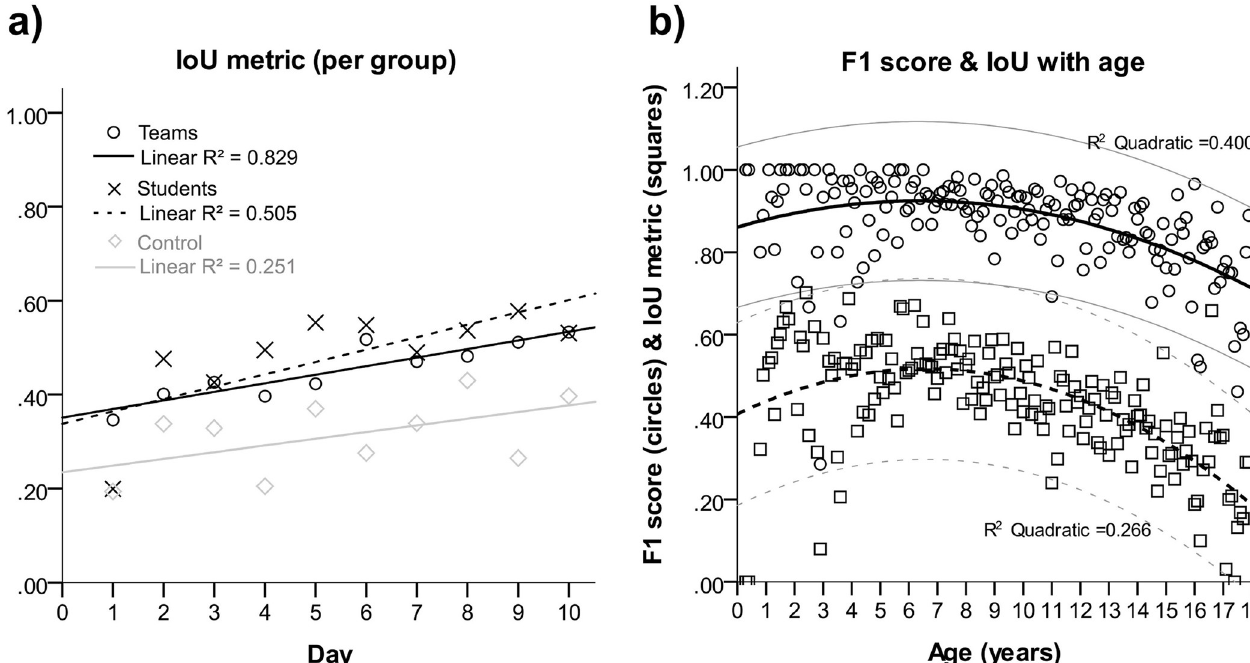
Fig 2. Image labeling precision during study period (a) and F1 scores and IoU metrics in relation to patient age (b). On image b quadratic curve fittings with 95% CI are displayed.